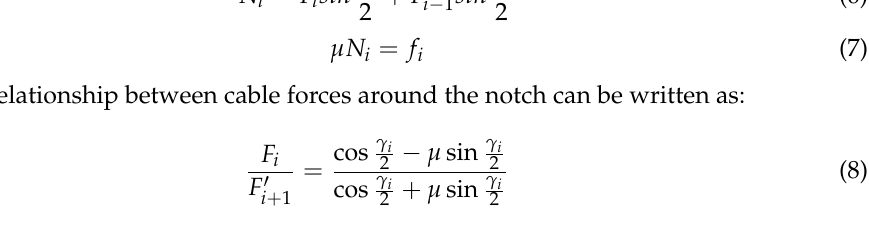
Table 1. The descriptions of each parameter in Figure 4.